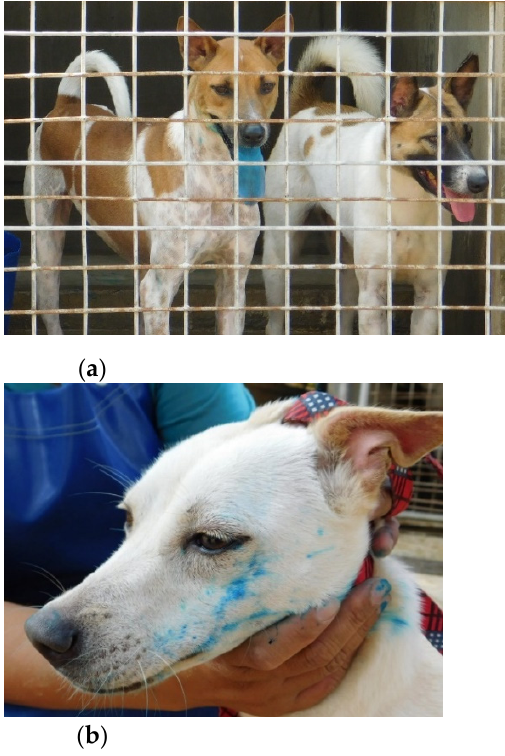
Figure 3. ( a , b ) Visibility of dye after bait consumption.